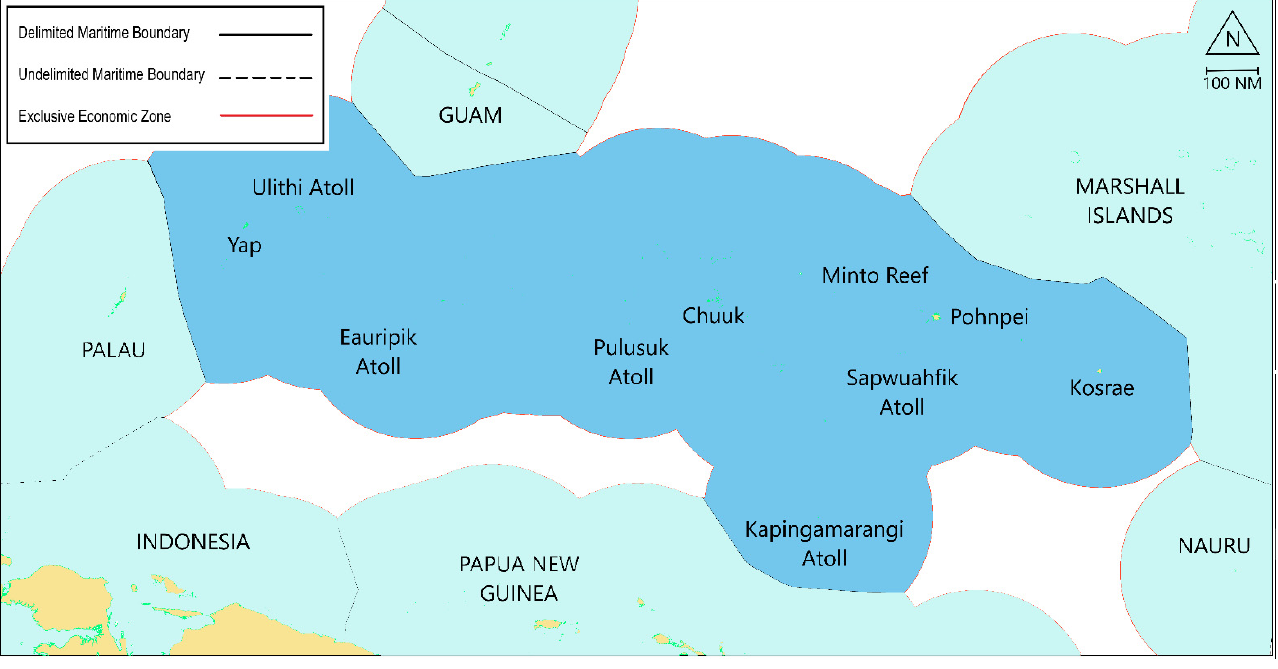
Figure 11. Location of FSM’s atolls and islands, including claimed EEZ areas and boundaries.